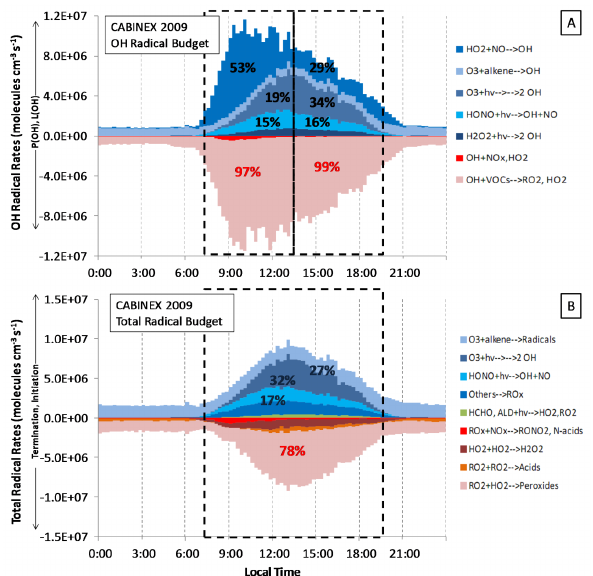
Figure 12: CABINEX 2009 radical budget diagrams showing the campaign median OH radical budget Fig. 12. CABINEX 2009 radical budget diagrams showing the cam- (A) that compares all the production and loss terms (i.e. initiation, termination, and propagation routes) paign median OH radical budget (A) that compares all the produc- for OH and the total radical budget (B) that groups and compares all initiation and termination reaction rates for OH, HO 2 , and RO 2 radicals. tion and loss terms (i.e., initiation, termination, and propagation routes) for OH and the total radical budget (B) that groups and com- pares all initiation and termination reaction rates for OH, HO 2 , and RO 2